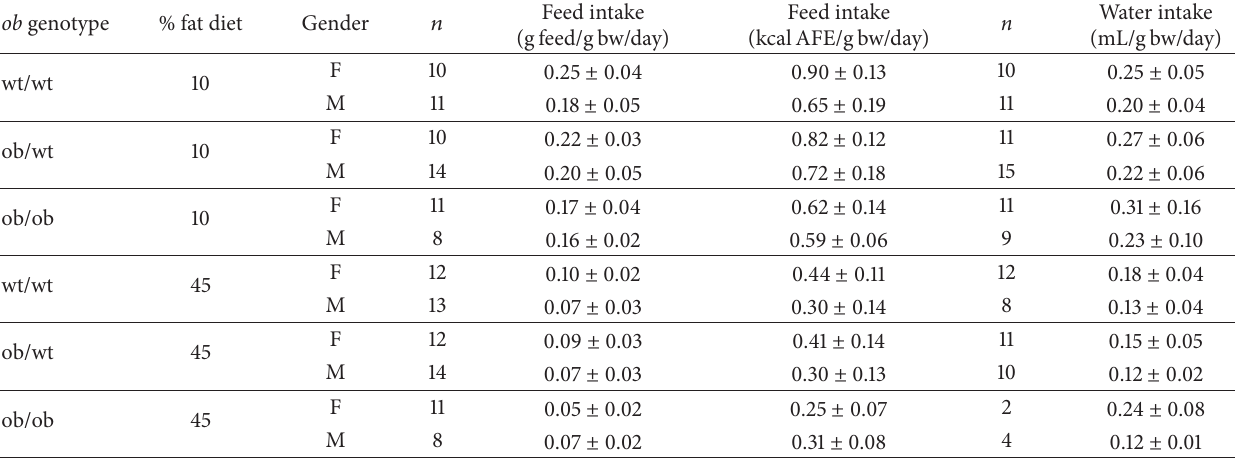
Table 1: Feed and water intake in mice kept in metabolic cages for 24